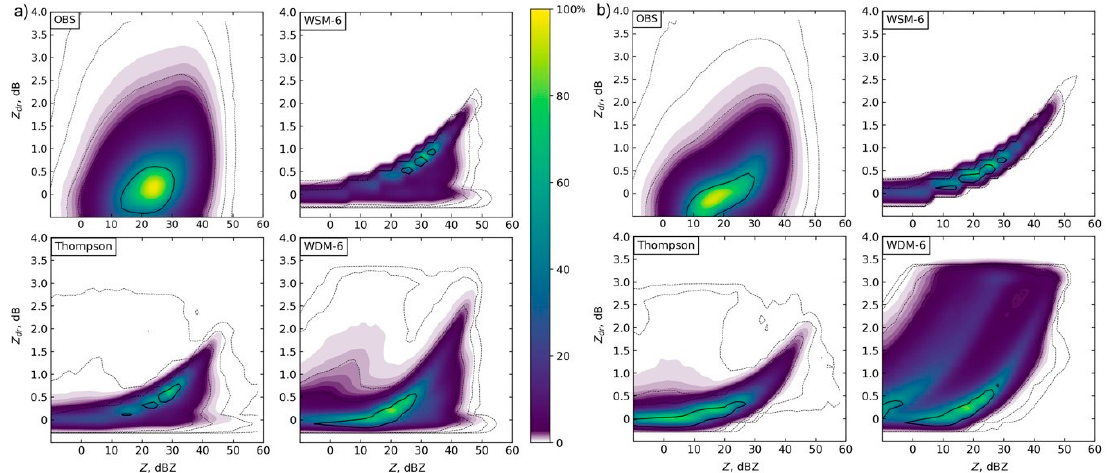
Figure 12. Normalized joint frequency distributions of Z H and Z DR (1 km model) for ( a ) AR1 and ( b ) AR2. Solid black contour represents 50%. Grey dotted lines represent 2.5, 1, 0.1, and 0.01%.